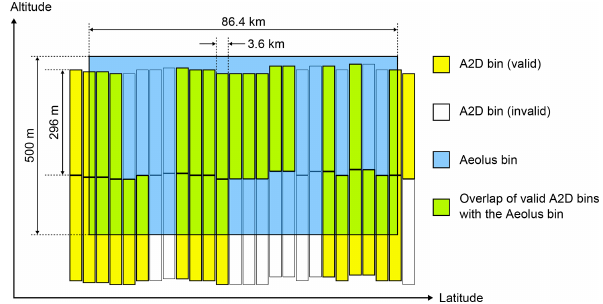
Figure 7. Schematic illustrating the different horizontal and verti- cal resolutions of Aeolus (blue bin) and the A2D (yellow bins) for typical range gate settings (Aeolus: 500m vertical resolution; A2D: 296m vertical resolution). White bins indicate invalid A2D obser- vations, while the green area represents the overlap of valid A2D bins with the Aeolus bin. For the aerial weighted averaging algo- rithm, the contributions of each valid A2D wind value to the wind value allocated to the composite bin are weighted by the overlap of the respective A2D bins with the Aeolus bin considered. The ratio of the green to the blue area is defined as the coverage ratio and is used as a quality control parameter (see Sect.